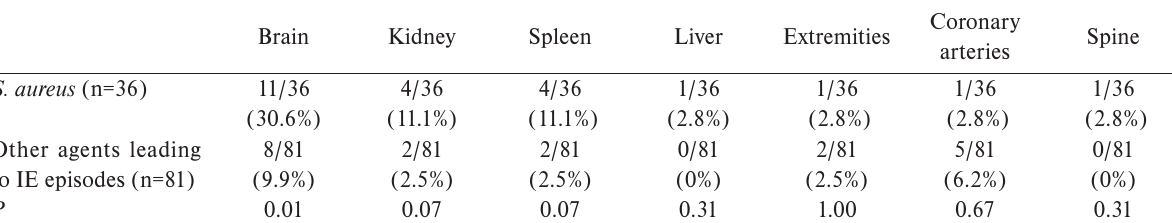
Table 2. Incidence of embolic episodes.